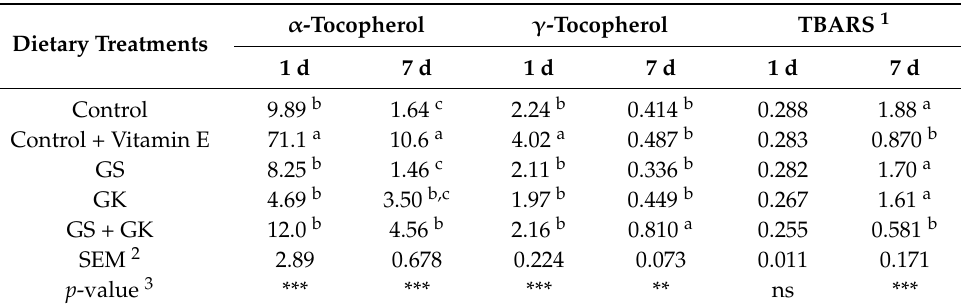
Table 7. Effect of refrigerated storage on lipid oxidation (mg MDA/kg) and α and γ tocopherol content ( µ g/g) in the thigh meat of broiler chickens fed diets containing grape seed (GS) meal, grape skin (GK) meal or vitamin E. Dietary